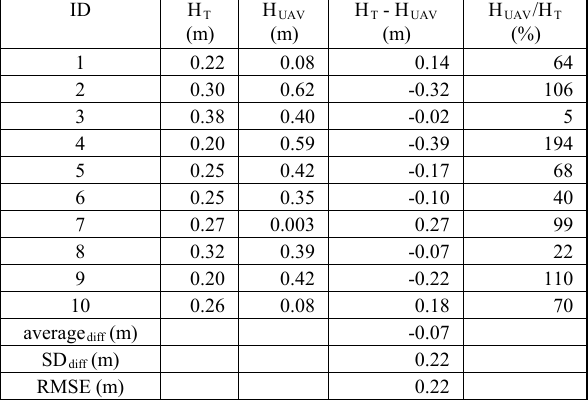
Table 3. Comparison of manual tube (H T ) and UAV (H UAV ) snow depth measurements in open area.